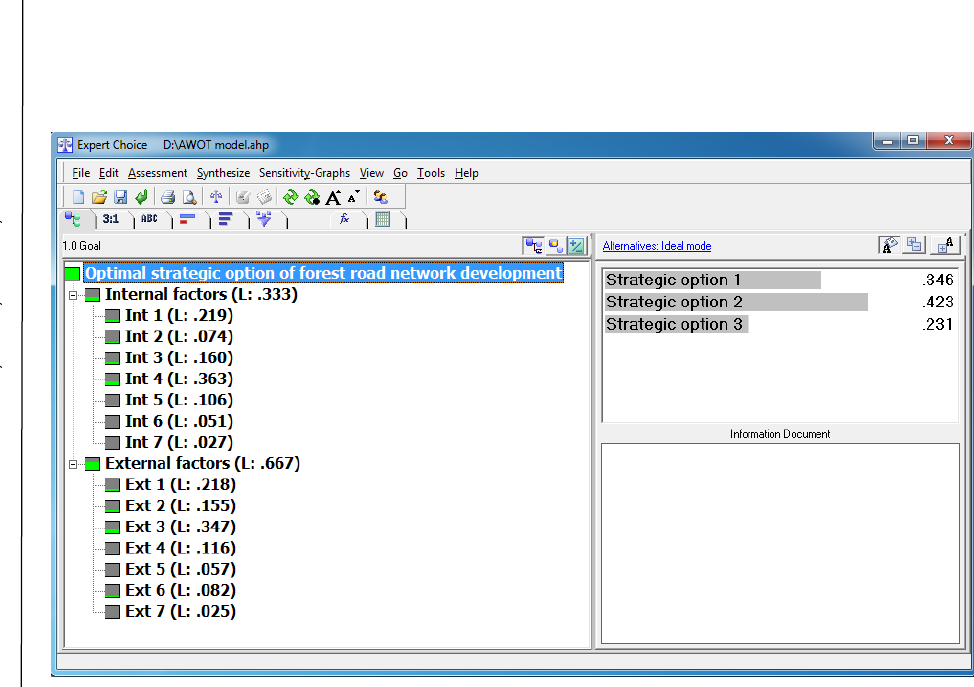
Figure 7 – The strategic options ranking results Рис . 7 – Результаты ранжирования стратегических вариантов Слика 7 – Резултати рангирања стратегијских